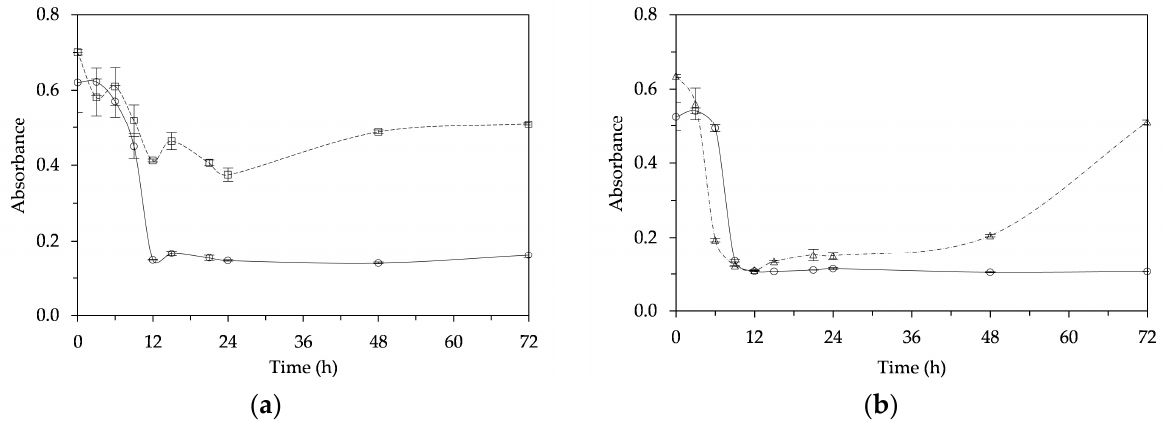
Figure 1. The absorbance change of L. plantarum SK15 broth and positive control broth that relate to amino acid decarboxylase production for ( a ) ornithine decarboxylase broth; ( b ) arginine dihydrolase broth.